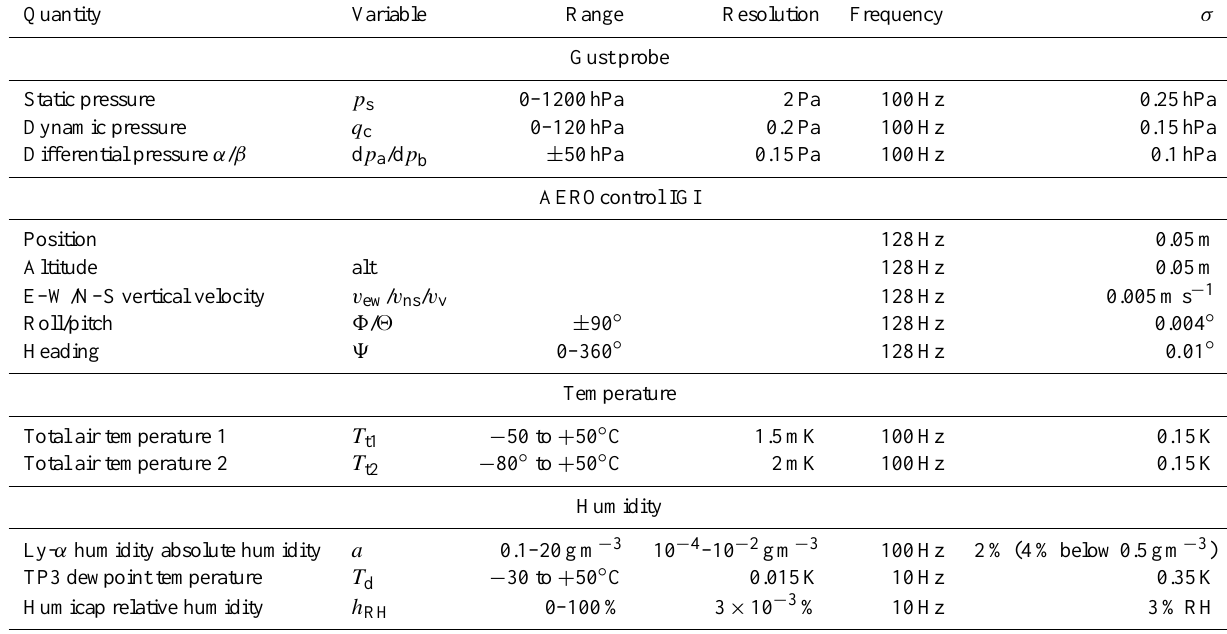
Table 3. List of the main measurement parameters included in the meteorological sensor package on the Caravan. The frequency describes the rate of recording after the appropriate filtering and σ is the overall uncertainty of the listed parameters including all errors such as sensor errors, temperature dependencies, analogue conversion or aerodynamic effects. With the in-house calibration equipment the results are traceable to national standards. The uncertainties in AEROcontrol IGI is according to the specifications of the manufacturer (Cramer, 2001). The uncertainties of derived parameters include the errors of all the involved parameters and